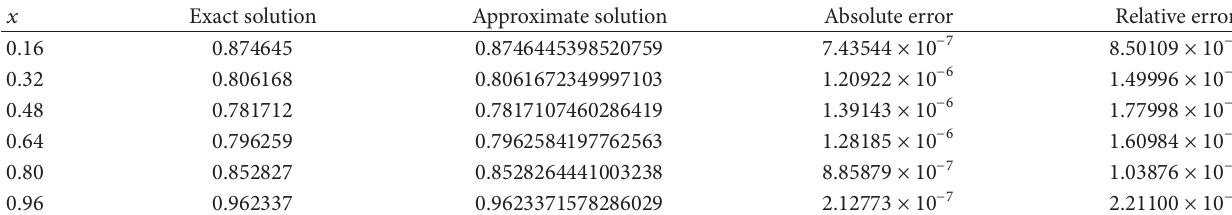
Table 8: Numerical results of 𝑢 3 (𝑥) for Example